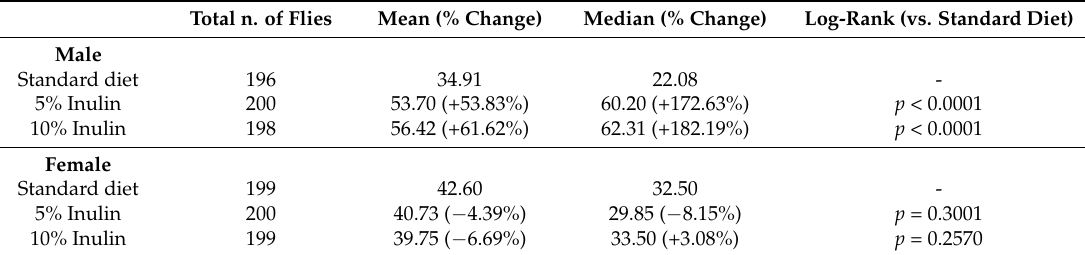
Figure 1. Lifespan analysis of InR p5545 /TM3 D. melanogaster fed an inulin-supplemented diet or a standard diet for male ( a ) and female ( b ) flies. Table 1. Statistics for survival curves. Cohort sizes, mean and median lifespans, percentage changes, and log-rank (Mantel-Cox) tests for survival curves in this study.